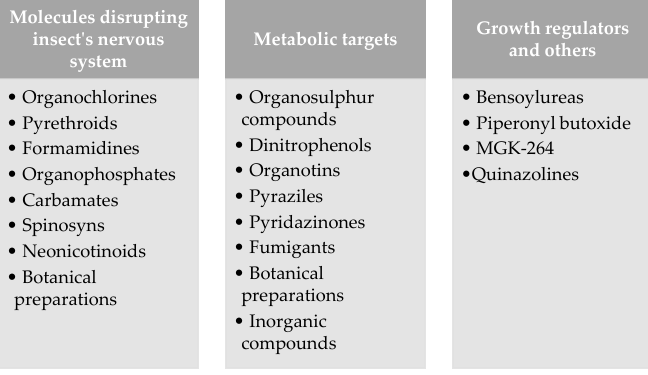
Figure 2. Major known targets for insecticidal activity.